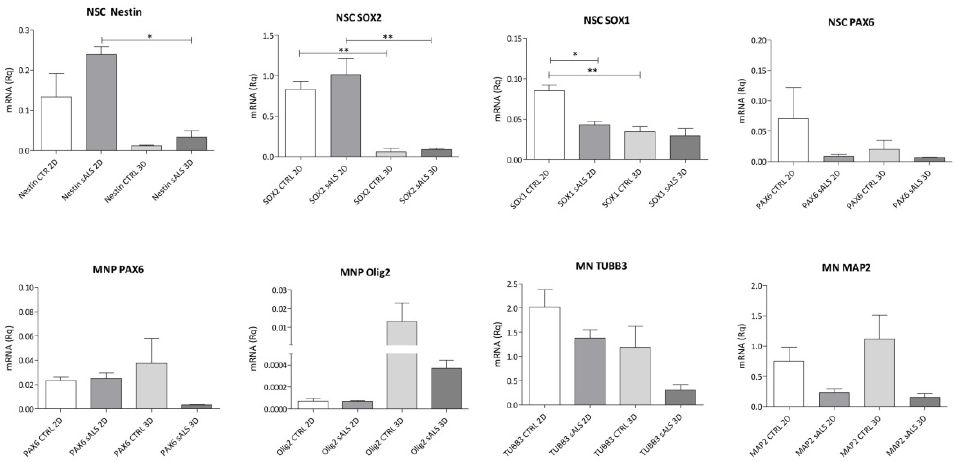
Figure 3. RT-qPCR confirms the expression of the typical markers during differentiation. The differentiation was confirmed using the markers for NSCs (Nestin, SOX2 , SOX1 and PAX6 ), MNPs ( PAX6 and Olig2 ) and MNs ( TUBB3 and MAP2 ). Error bars indicate SD. Data were analyzed using ANOVA, followed by the Bonferroni test. * p < 0.05; ** p < 0.01 (GraphPad Prism 8).